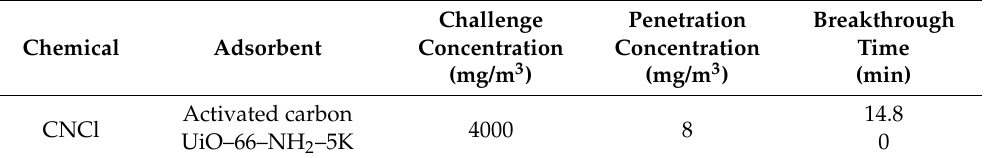
Table 5. Comparison of breakthrough time and protective dose of CNCl between UiO–66–NH 2 –5K and impregnated carbon-based carbon